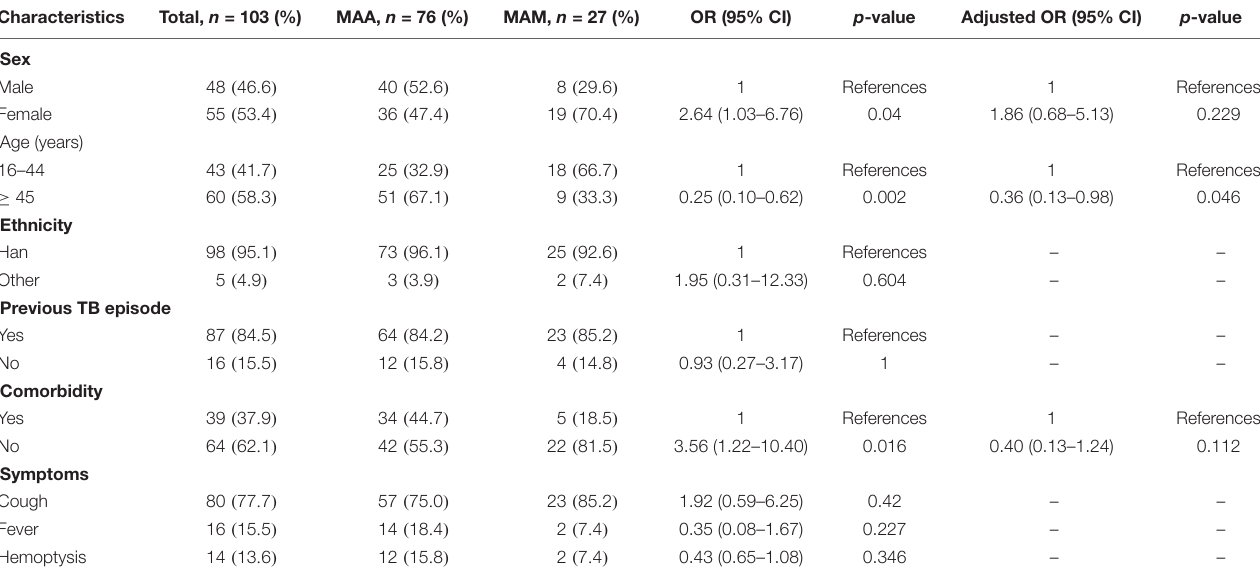
TABLE 1 | Differences in the characteristics between Mycobacterium abscessus subsp. abscessus (MAA) and M. abscessus subsp. massiliense (MAM).